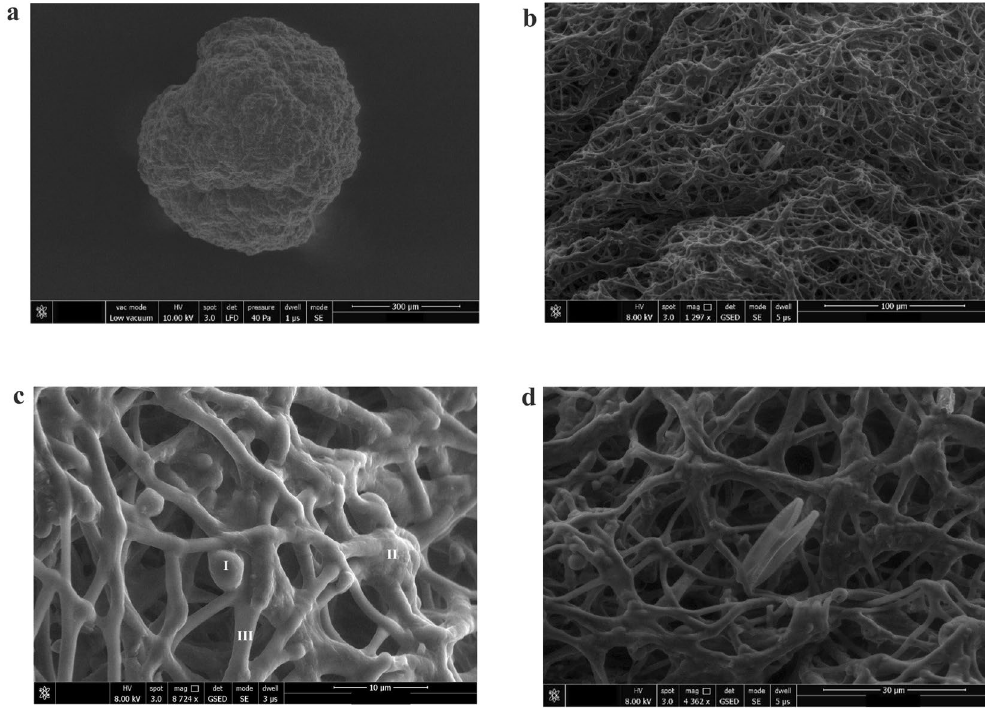
Figure 6. SEM images of the activated algae granule. ( a ) Activated algae granule with emphasis on ( b ) granule structure, and ( c ) inside populations: target microalgae Chlorella sp. (I), bacterial biomass (II), filamentous microalgae (III), and ( d ) Nitzchia palea